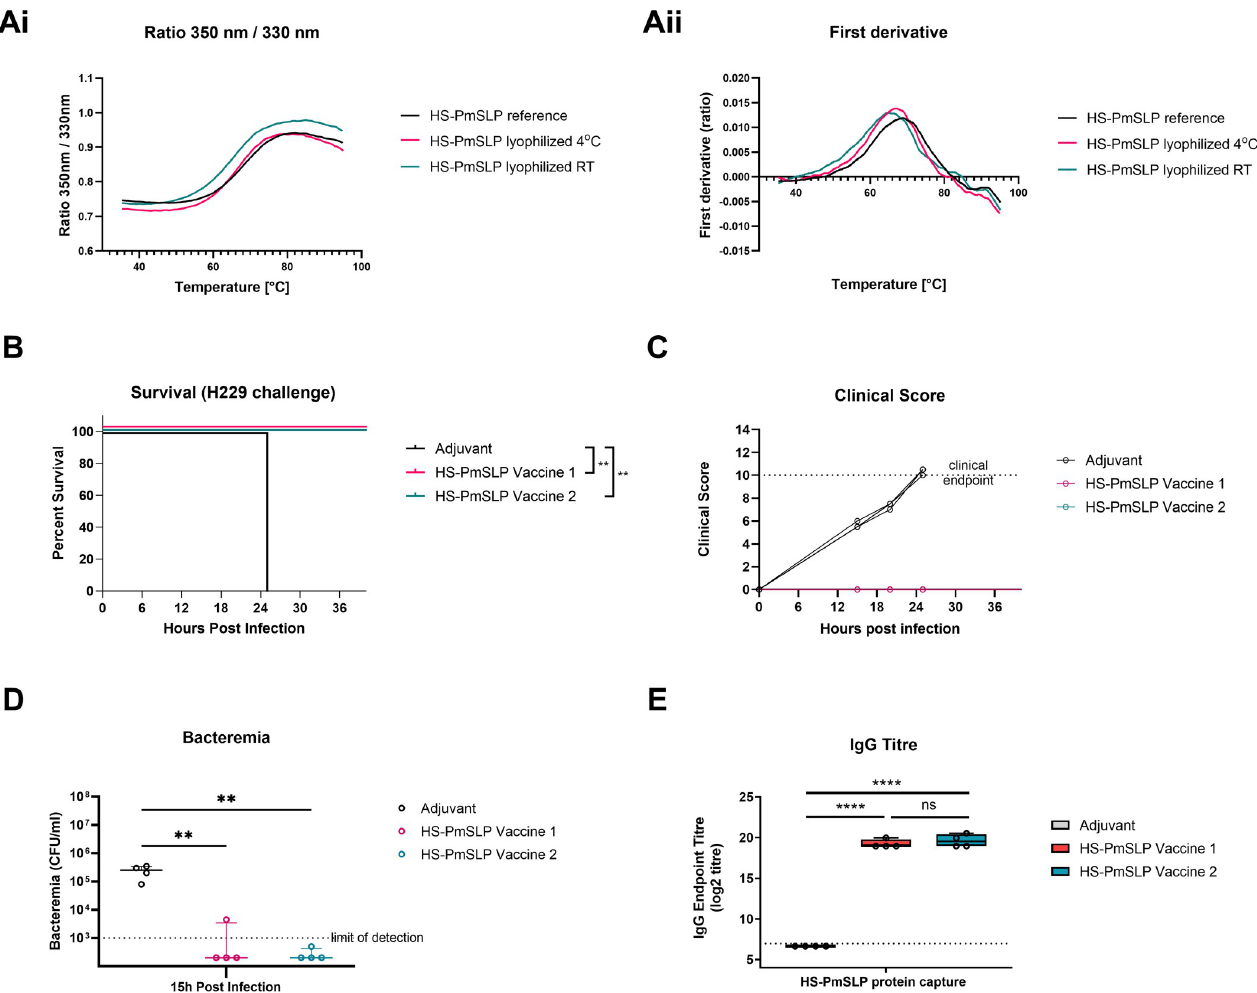
Fig 5. Long term stability of PmSLP antigens. A. Comparison of (i) thermal profile and (ii) first derivative of HS-PmSLP protein lyophilized and stored at 4˚C or room temperature for 1 year. B. Survival of mice that received different HS-PmSLP vaccine preparations after challenge with the matched strain H229. Vaccine 1, HS-PmSLP antigen stored at -80˚C for 1 year after purification. Vaccine 2, lyophilized HS-PmSLP stored for 1 year at 4˚C. Both vaccines were formulated immediately prior to each dose administration. N = 4 mice for adjuvant control, N = 4 mice for each vaccinated group. Log-rank (Mantel Cox) tests performed for survival curve comparisons; ** , p < 0.01. C. Clinical scores of individual mice over 48 hours post intraperitoneal challenge. D. Bacteremia in tail vein sample at 15h post infection. Line at median, error bars depict interquartile range. Ordinary 1-way ANOVA with Dunnett’s multiple comparison test performed to compare vaccinated groups to adjuvant control. ** , p < 0.01. E. Serum IgG titre in vaccinated or control animals against the purified protein antigen. Boxplot with individual animals is shown. 1-way ANOVA with Tukey’s multiple comparisons test performed to compare each group to all other groups using log2 transformed data. **** , p < 0.0001; ns, not significant.